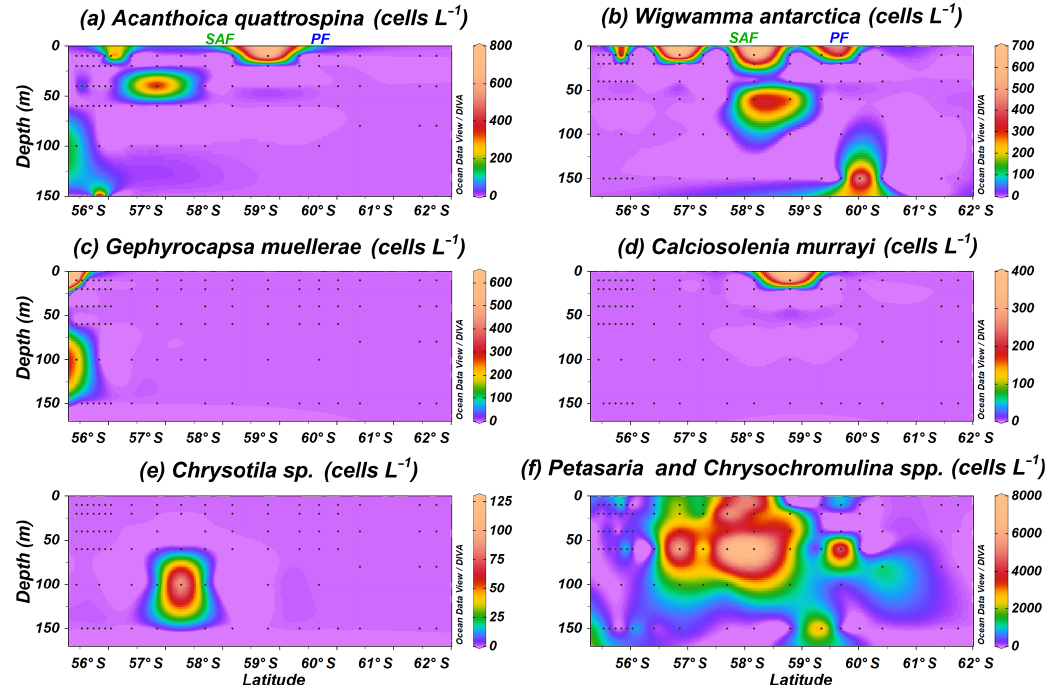
Figure 7. Location of the PS97 CTD stations studied, showing the number of coccospheres per litre of (a) Acanthoica quattrospina , (b) Wig- wamma antarctica , (c) Gephyrocapsa muellerae , (d) Calciosolenia murrayi , (e) Chrysotila sp., and (f) Petasaria and Chrysochromulina spp. The Subantarctic Front (SAF) and the Polar Front (PF), according to Orsi et al. (1995), are indicated.